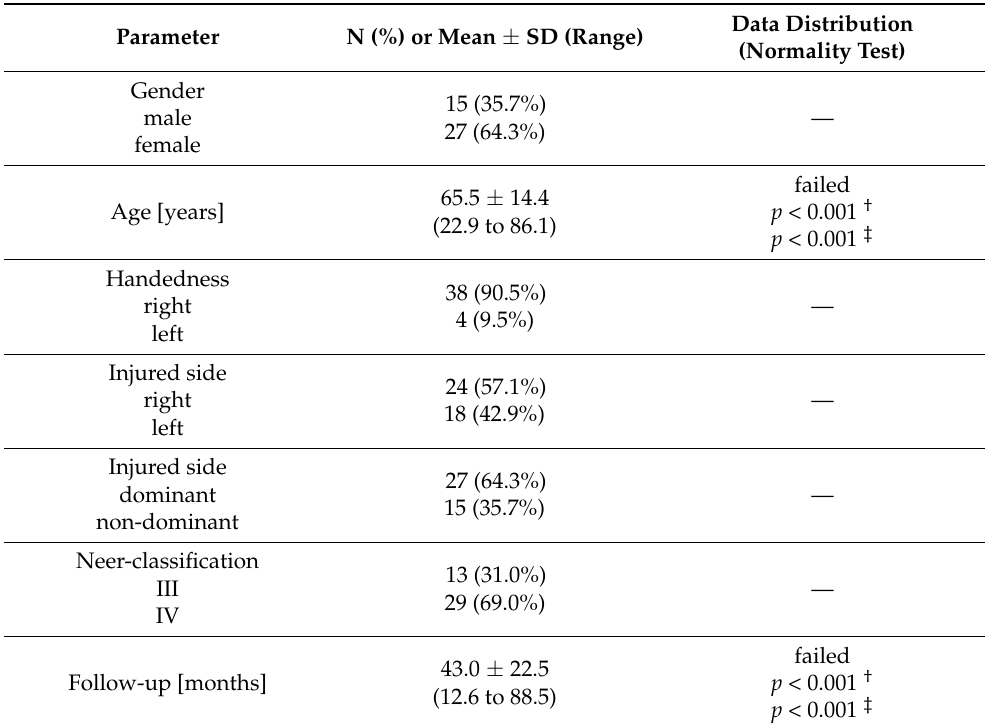
Table 2. Demographics, radiographic assessment, and functional outcome in 42 patients with humerus